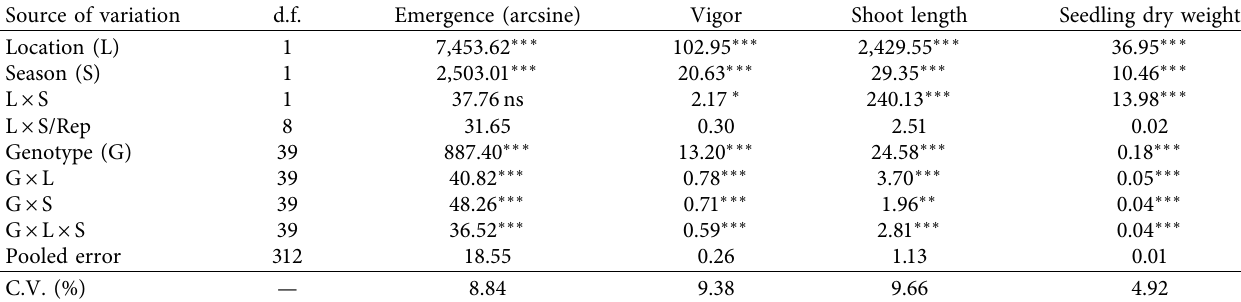
Table 3: Mean squares of field trials for all observed traits and their interactions across all locations and seasons.